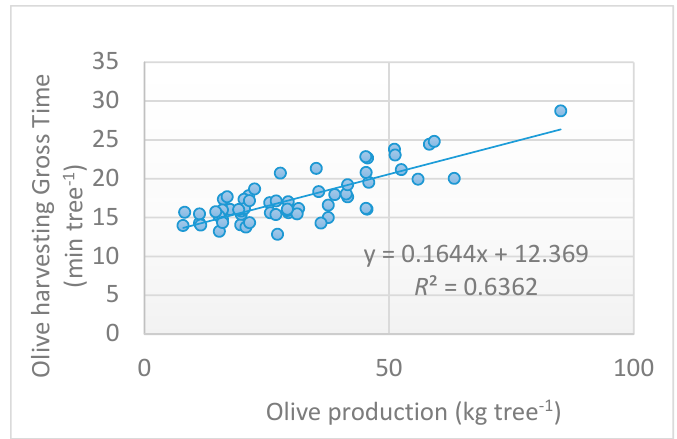
Figure 8. Olive harvesting gross time per tree expressed as a function of olive production.